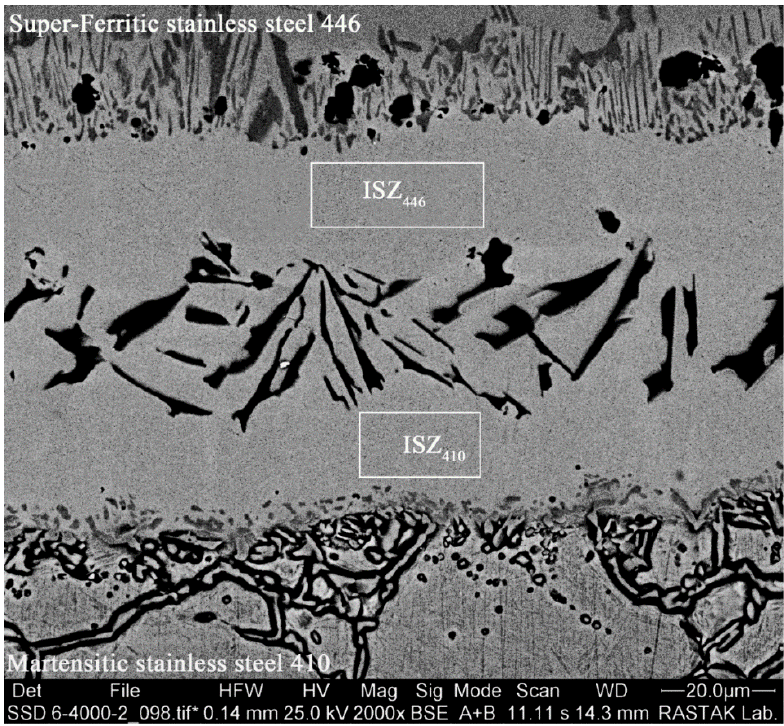
Figure 8. The SEM microscopy of a bonded sample at 1050 °C/15 min condition. Table 4. EDX analysis of various phases indicated in Figure 8 (wt.%).